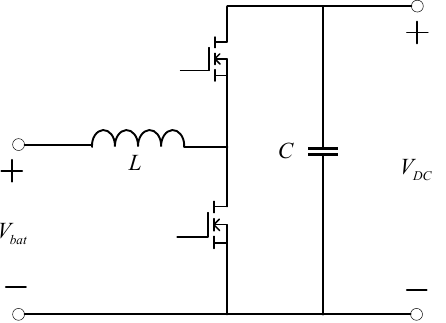
Figure 5. The topology of the bidirectional DC/DC transformer.